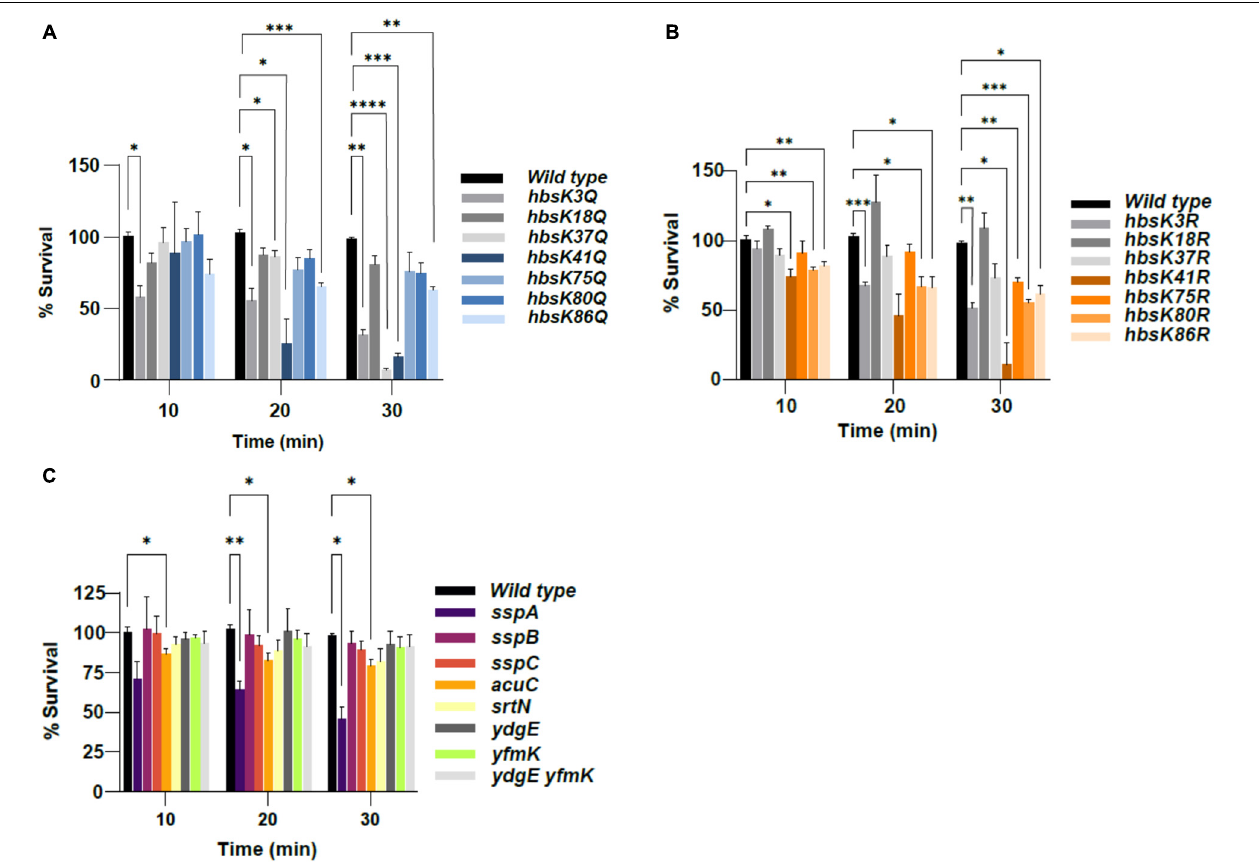
FIGURE 2 | The effects of acetylation on heat resistance. B. subtilis spores were isolated following growth in sporulation media for 48 h. Spores were diluted and subsequently exposed to heat for a total of 30 min. At 10 min intervals, spores were plated for viable counts, and the survival percentage was calculated as heat-resistant colony forming units (CFUs)/ml divided by total viable counts (CFU/ml), pre-heat treatment. Bar graphs represent the average percentages determined from three independent replicates with error bars representing standard deviations. All time points were normalized to the zero time point for each strain (not displayed), which was set at 100%. The strains used in (A–C) were as described in the legend for Figure 1 . Statistical analyses were performed using GraphPad Prism 9. Two-factor ANOVAs with repeated measures, and a post hoc Dunnett square analysis were used to determine statistical significance. A p -value of ≤ 0.05 was considered significant. ∗ p < 0.05, ∗∗ p < 0.01, ∗∗∗ p < 0.001, ∗∗∗∗ p <